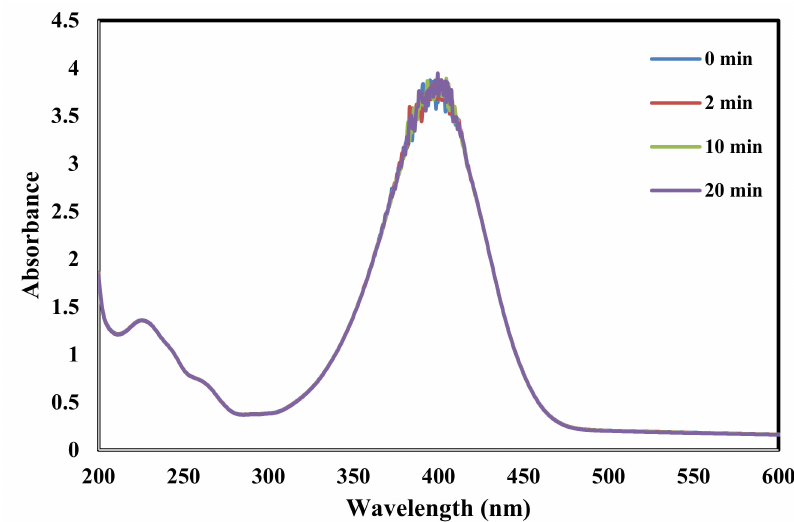
Figure 10. Time-dependent UV–vis spectra for monitoring 4-nitrophenol reduction by catalyzed by ZnONPs under the conditions of 20 mL of 50 ppm 4-nitrophenol, 2 mL of H 2 O 2 , 0.3 g of Catalyst, 25 ◦ C, 250 rpm for 20